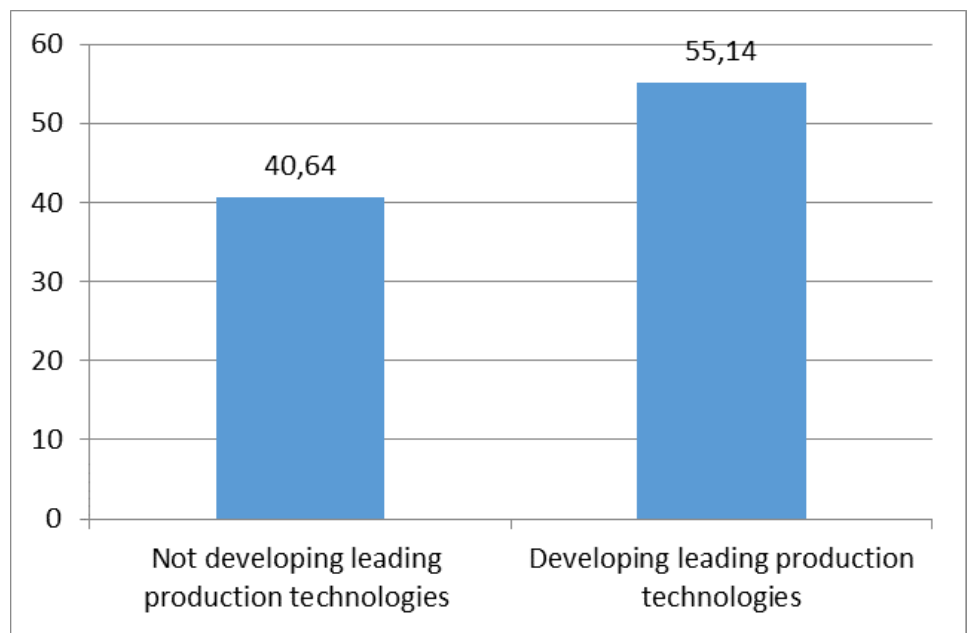
Figure 9: Average values of share of companies implementing energy-efficiency innovations by group of regions that performed (or didn’t perform) development of leading production technologies